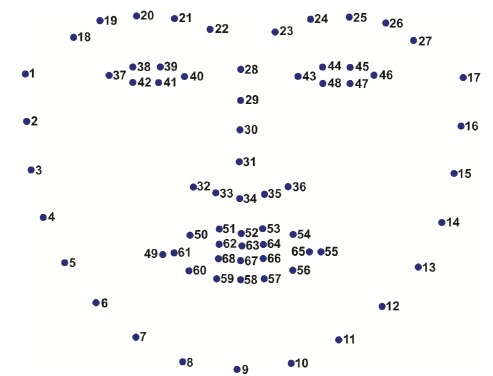
Figure 2. Illustration of 68 landmarks on a human